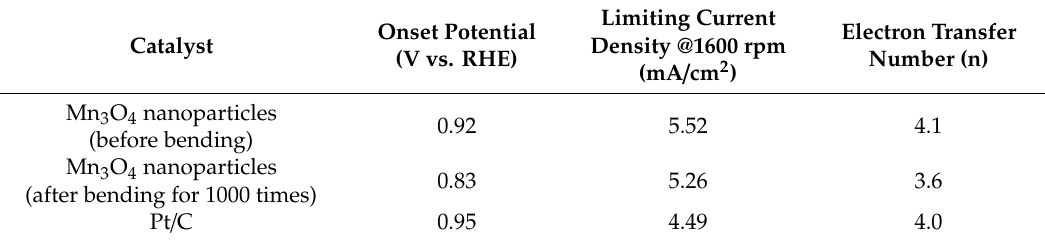
Figure 8. ( a ) ORR polarization curves of the air cathodes and ( b ) discharging voltage / power density profiles before and after bending for 1000 times. Table 2. ORR activities and kinetics for di ff erent